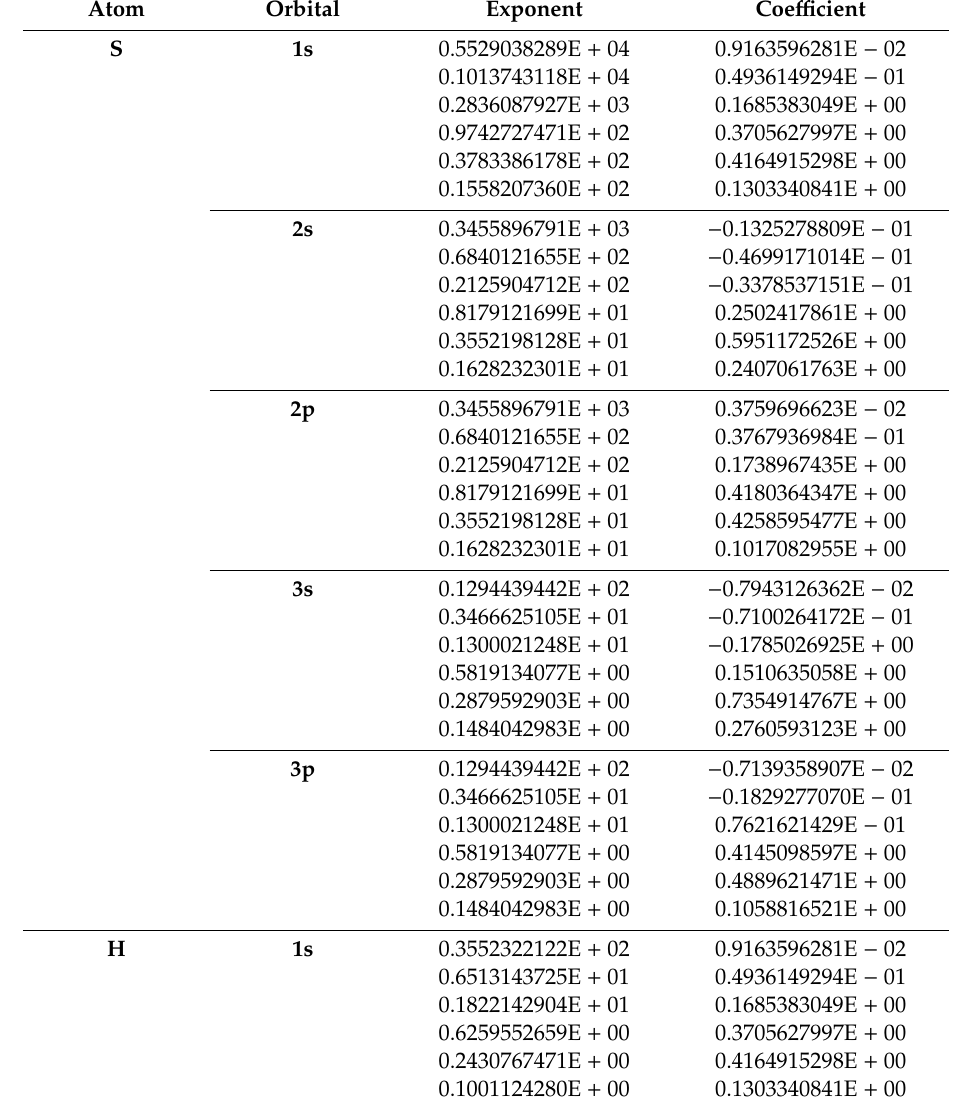
Table 2. Calculated values of exponents α kj and coe ffi cients c kj of STO-6G orbitals of H 2